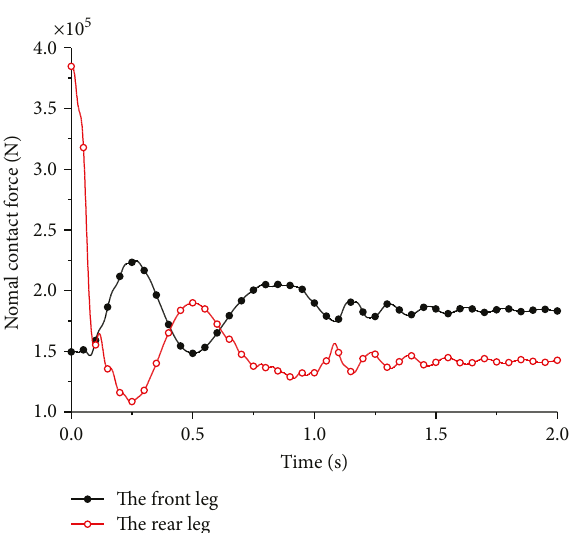
Figure 12: Contact force of legs in the normal direction.